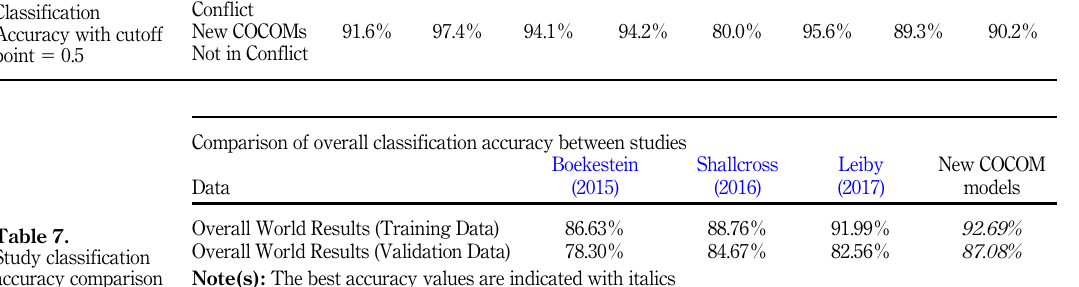
Accuracy with cutoff point 5